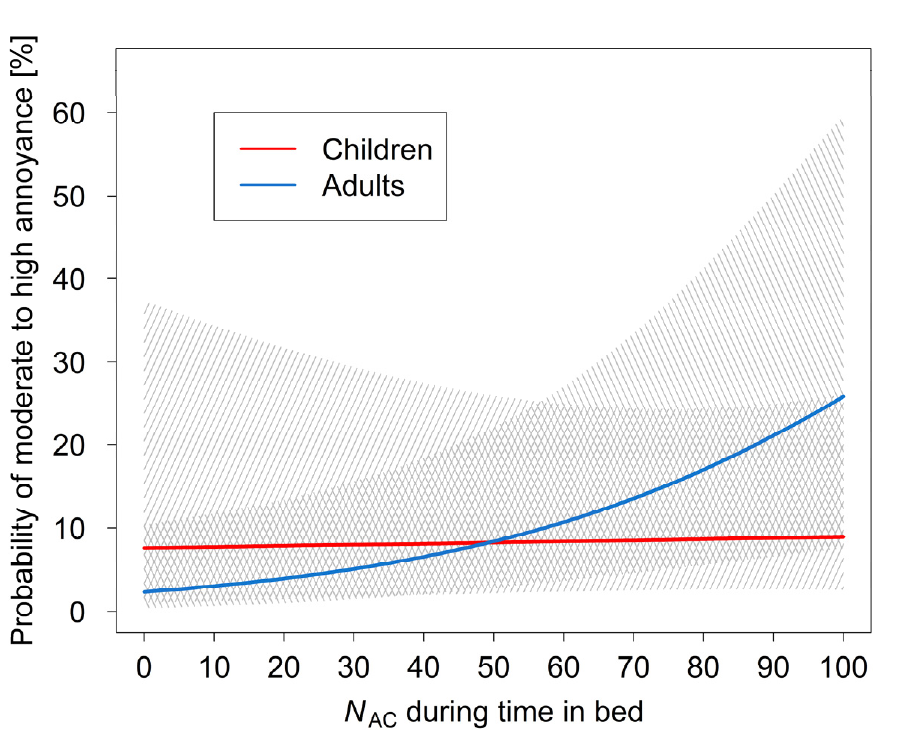
Figure 4. Probability for annoyance (categories ≥ 3) by aircraft noise of the previous night as predicted by model LR4 depending on N AC with corresponding 95% CI (hatched area).